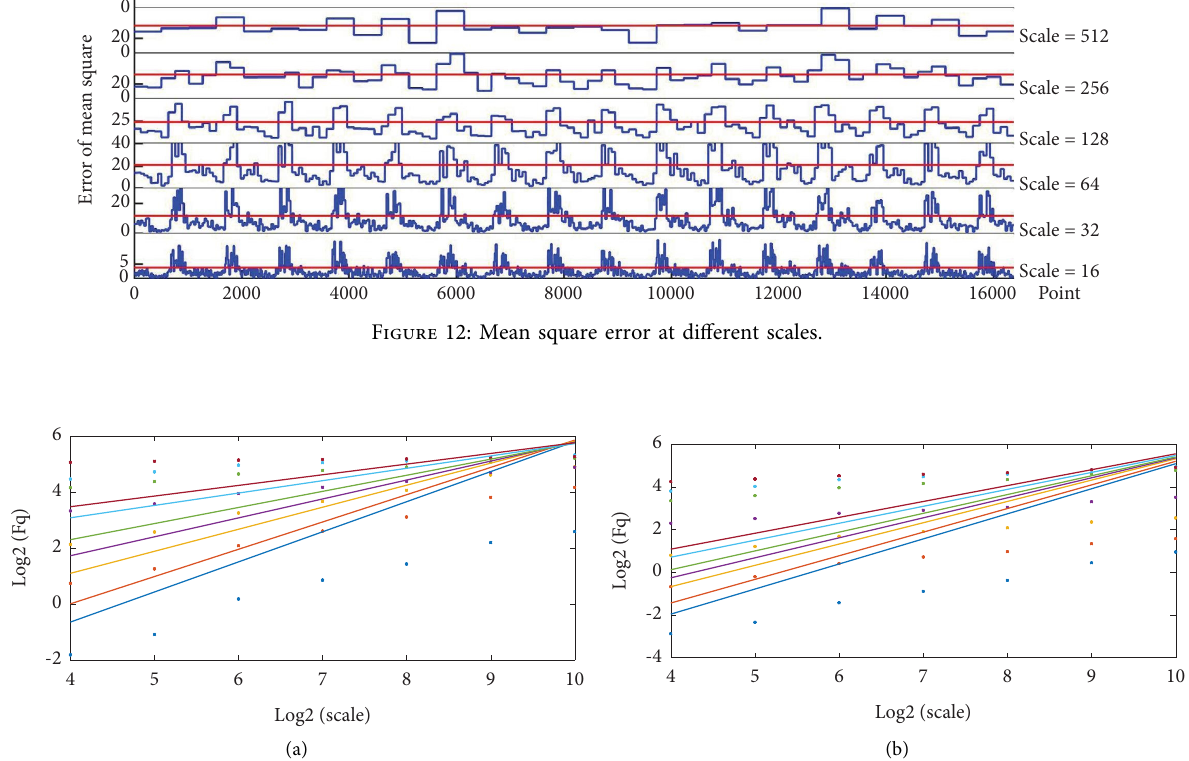
Figure 13: Logarithmic regression line of wave function and scale. (a) Early function. (b) Late function.